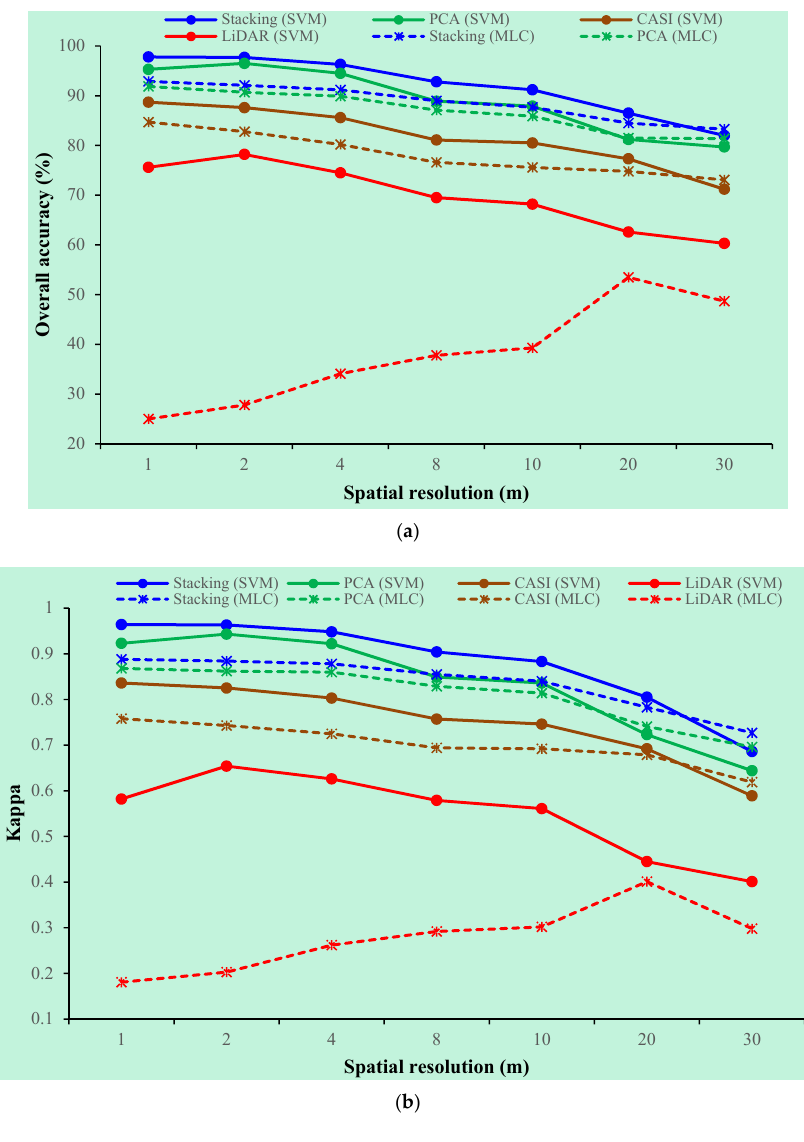
Figure 6. Comparison of the classification accuracies using different classifiers, datasets and spatial resolutions; ( a ) overall accuracy and ( b ) kappa coefficient. Table 4. Per-class accuracies obtained with the highest overall accuracy produced by the support vector machine (SVM) and maximum likelihood (MLC) classifiers for layer stacking fusion data at a 1 m spatial resolution. The accuracies included the producer’s accuracy (PA), user’s accuracy (UA), error of commission (EC) and error of omission (EO).